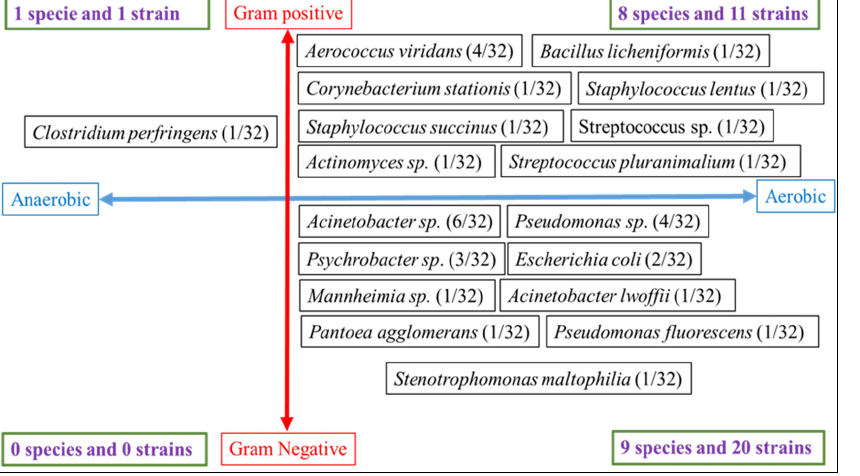
Figure 1. Features of the bacterial isolates (growing in aerobic vs. strict anaerobic environment and gram-positive vs. gram-negative strains) identified in the positive samples (19/76) [24].